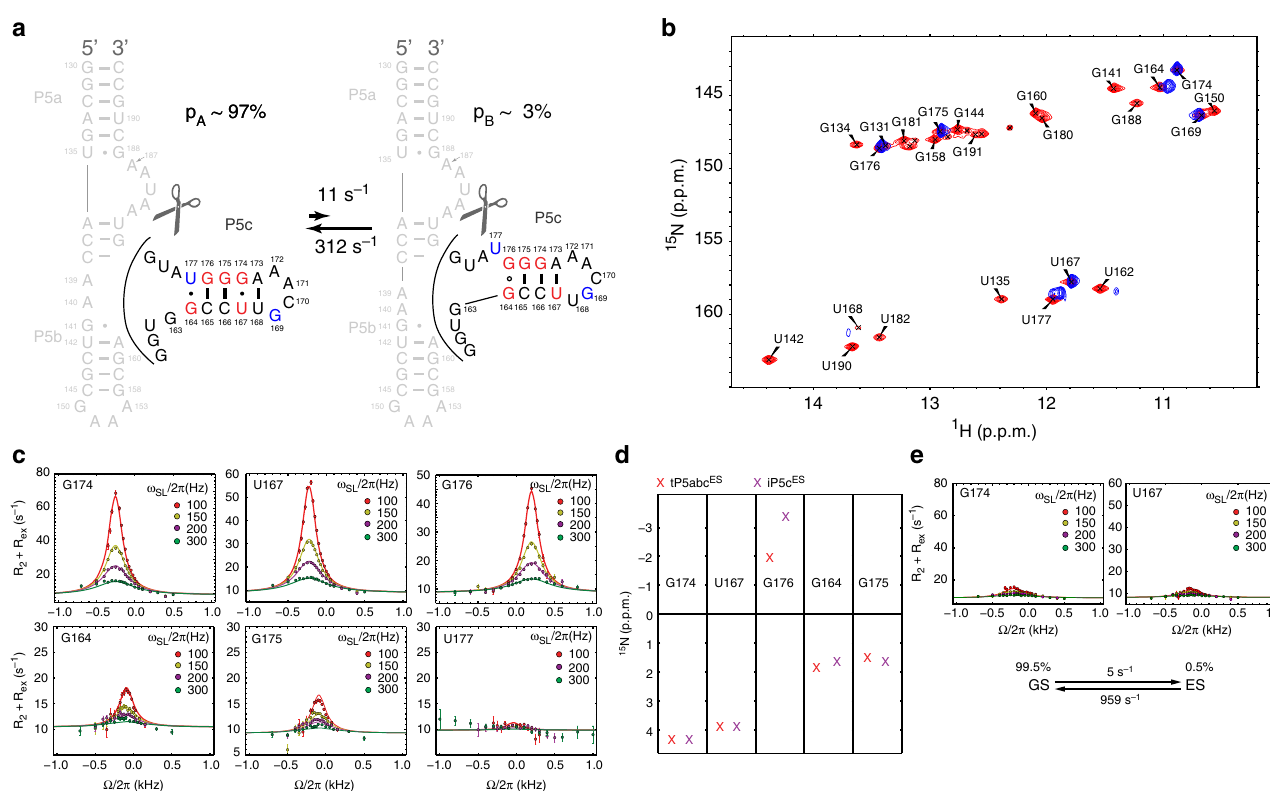
Figure 6 | Modular exchange in P5c. ( a ) Secondary structure of isolated P5c construct (iP5c). Residues showing RD are coloured in red, residues showing no RD in blue, and those without observable imino resonances in 2D HSQC spectra in black. Exchange parameters are obtained from global fitting the RD profiles using two-state exchange model and Laguerre equation. ( b ) 2D 1 H- 15 N HSQC spectrum of 1mM iP5c (blue) overlaid on spectrum of WT tP5abc (red) in 10mM sodium phosphate and 0.01mM EDTA (pH 6.4) at 10 (cid:2) C. ( c ) Off-resonance R 1 r RD profiles of iP5c in the absence of Mg 2 þ . ( d ) Comparison of ES chemical shifts measured in iP5c and tP5abc. ( e ) Off-resonance RD profiles of iP5c in the presence of 1mM free Mg 2 þ .